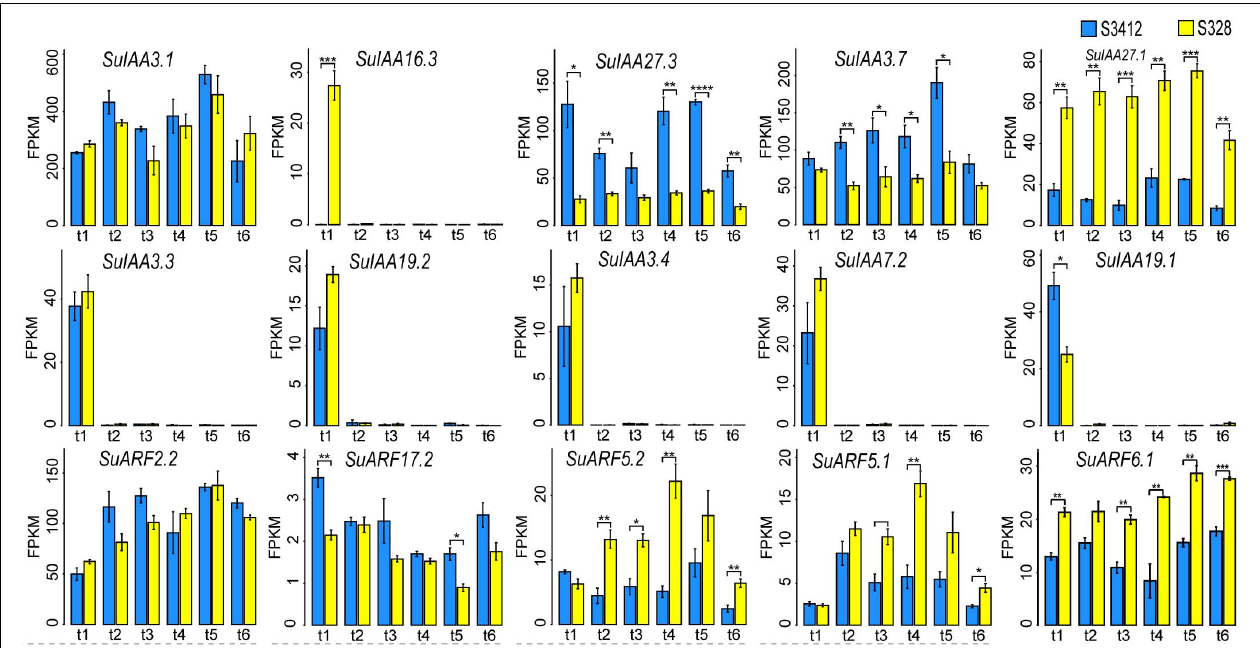
FIGURE 4 | The time-sequential transcriptome profilings of some SuIAA and SuARF genes in two contrasting clones “S328” and “S3412.” The X -axis shows the different sampling time points (t1: 45 days after planting; t2: 75 days after planting; t3: 135 days after planting; t4: 195 days after planting; t5: 240 days after planting; and t6: 270 days after planting). The Y -axis represents the fragments per kilobase of transcript per million fragments mapped (FPKM) value, which are the mean ± SD of three replicates, and the P -values are shown as * P < 0.05, ** P < 0.01, *** P < 0.001, and **** P < 0.0001.